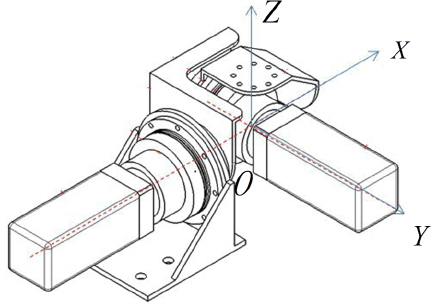
Figure 4. Haptic interface coordinate